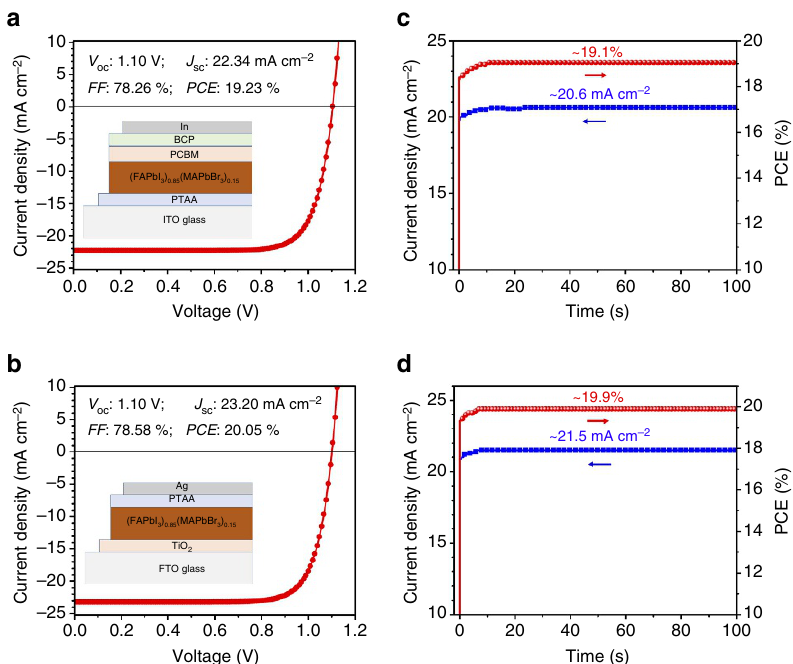
Figure 4 | Photovoltaic performances of FA 0.85 MA 0.15 PbI 2.55 Br 0.45 perovskite solar cells. ( a ) Current density–voltage ( J – V ) characteristic of the inverted planar FA 0.85 MA 0.15 PbI 2.55 Br 0.45 perovskite solar cell. The device architecture is shown as an inset. ( b ) J – V characteristic of the standard planar perovskite solar cell. The device architecture is shown as an inset. ( c ) Photocurrent density and the corresponding efficiency of the inverted planar perovskite solar cell measured as a function time at a constant forward bias of 0.925V under an AM1.5G standard sunlight. ( d ) Photocurrent density and the corresponding efficiency of the standard planar perovskite solar cell measured as a function time at a constant forward bias of 0.925Vunder an AM1.5G standard sunlight.